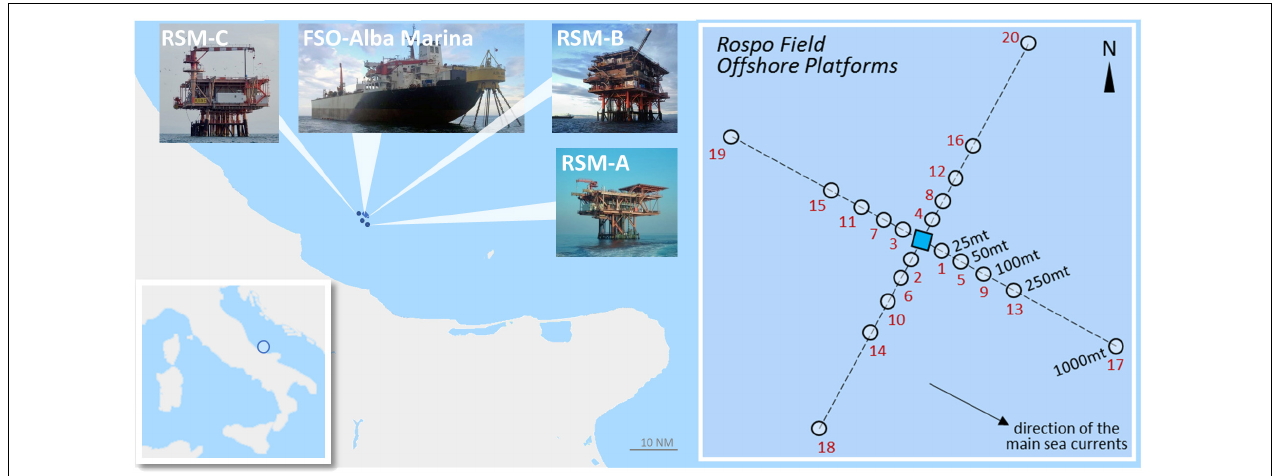
FIGURE 1 | Geographical localization of Rospo Mare field and representative experimental sampling design: scale NM, nautical miles. For each of the three off-shore platforms the following analyses (samples) were performed: chemical characterization of sediments (samples 1–20); benthic communities (samples 1–20 in triplicate); ecotoxicological bioassays (samples 5–8, 17, 17bis, 19, and 19bis); bioavailability of metals from sediments to laboratory exposed polychaetes (samples 5–8, 17, 17bis, 19, and 19bis); bioavailability of metals and organic pollutants in mussels (both native organisms and transplanted on the platforms); biomarkers in mussels (both native organisms and transplanted on the